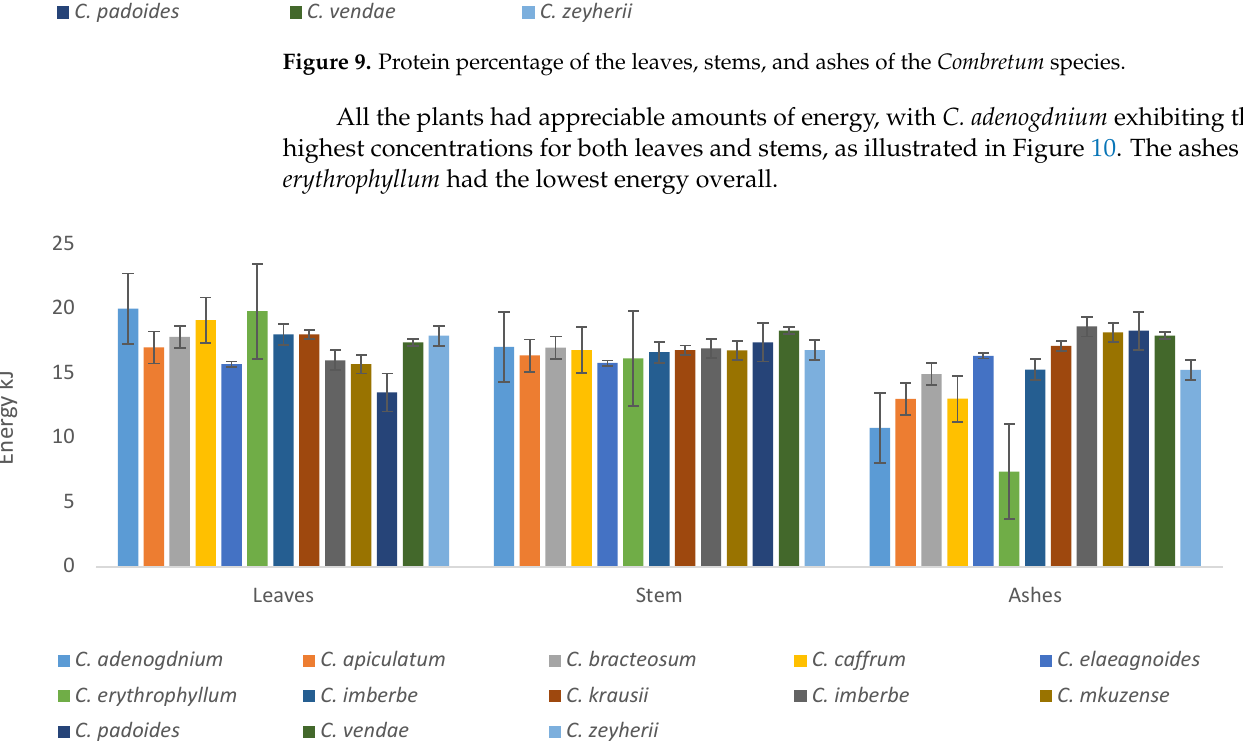
Figure 10. Energy content of the leaves, stems, and ashes of the Combretum plants tested in the study. 3.3.4. Mineral and Trace Metals Composition of the Leaves The minerals detected in the leaves ranged from 4.86–283 (Ca); 0.114–166 (Co); 0.15–0.661 (Cu); 0.209–3.19 (Fe); 2.98–65.5 (K); 2.03–51.2 (Mg) 0.0319–3.98 (Mn); 1.84–13.7 (Na); 0.0139–3.5 (Ni); and 0.006–1.04 (Zn). C. elaegnoides had the lowest concentrations of minerals apart from Mg and Zn. C. adenogonium had the highest Ca, Cu, and Fe concentration while C. apiculatum had the highest concentration of Co, K, Mg, and Mn (Table 5). Table 5. Concentration (mg/mL) of trace minerals in the leaves of some Combretum species.